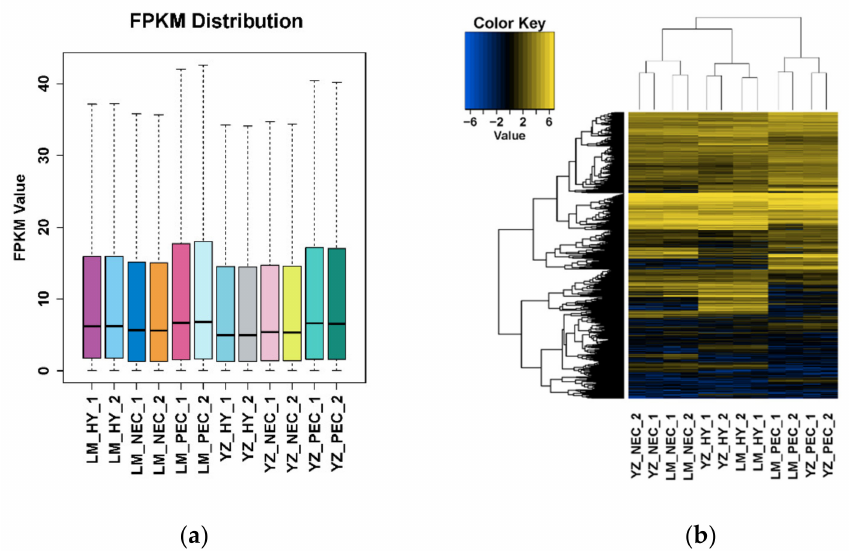
Figure 1. Overall data analysis for the transcriptome assays during cotton SE in two genotypes. ( a ) Fragments Per Kilobase Million (FPKM) distribution in di ff erent developmental stages during Somatic embryogenesis (SE) in Lumian 1 (LM) and Yuzao 1 (YZ); ( b ) Hierarchical clustering of transcripts in di ff erent developmental stages during early SE in LM and